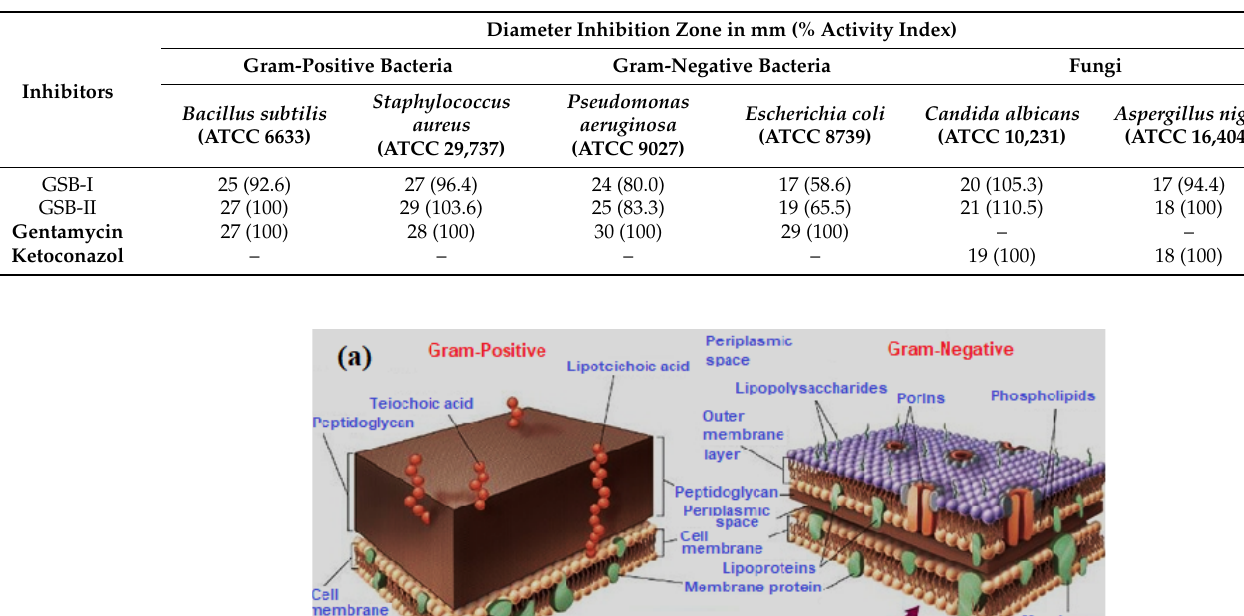
Table 3. Anti-bacterial and anti-fungi activities of a synthesized gemini Schiff base.